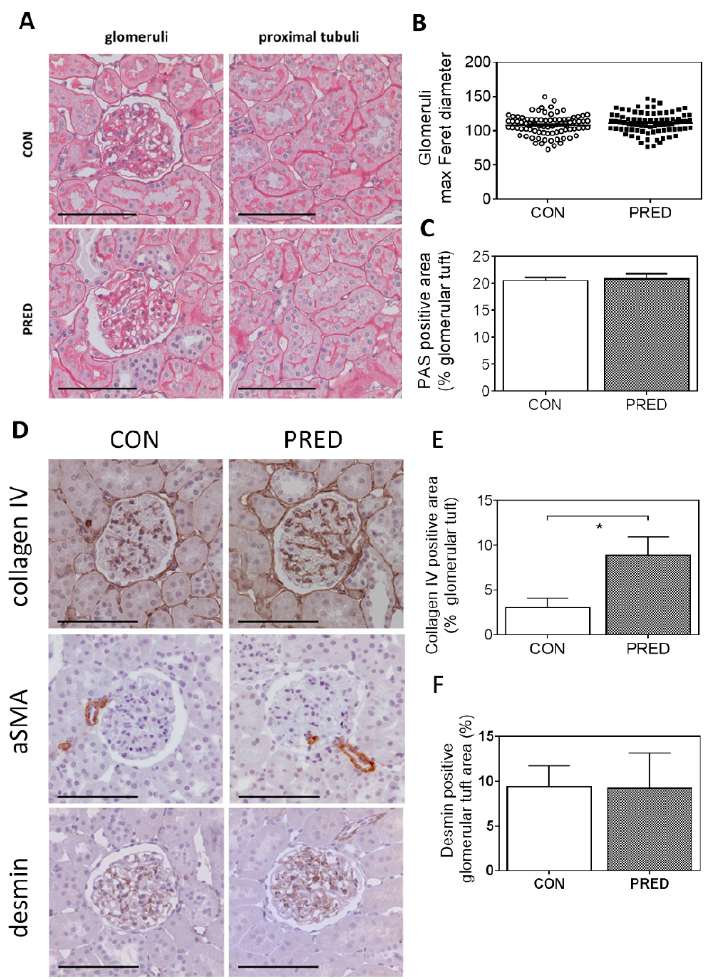
Figure 5. Kidney histology and immunohistochemistry. ( A ) Representative images of periodic-acid-Schiff (PAS) stained glomeruli (left) and proximal tubuli (right) in CON (above) and PRED rats (below). ( B ) The glomerular size indicator maximal Feret diameter; ( C ) PAS positive area relative to total glomerular tuft area. ( D ) Representative images of collagen IV, alpha-smooth muscle actin ( α SMA) and desmin immunohistochemistry; ( E ) relative collagen IV positive and ( F ) desmin positive area of the glomerular tuft in control (CON, left) and prediabetic (PRED, right) rats. Photos were taken at 200x magnification; scale bar = 100 μ m; data are means ± SEM, n = 9 samples/group, each data point represents mean of 20 glomeruli/samples. Unpaired two-tailed Student’s t-test ( B , C , E , F ); *: p < 0.05. 2.3. Known mRNA and miRNA Markers of Renal Fibrosis were Unaffected in PRED Rats